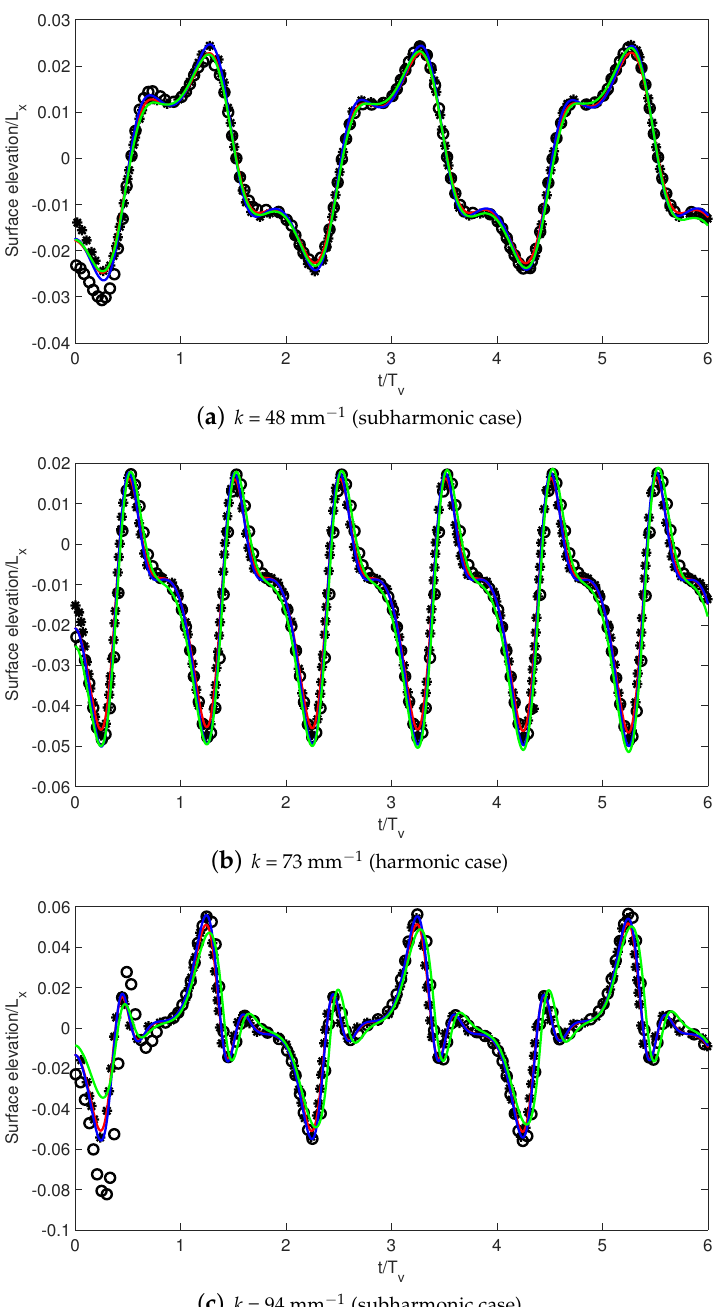
Figure 2. Comparison of the interface position at x = L x /2 in linear regime cases. ( ◦ ) Linear analysis [15], ( ∗ ) PF S [15], (–) EbFVM S (this work), (–) FT S (this work), (–) VOF S (this